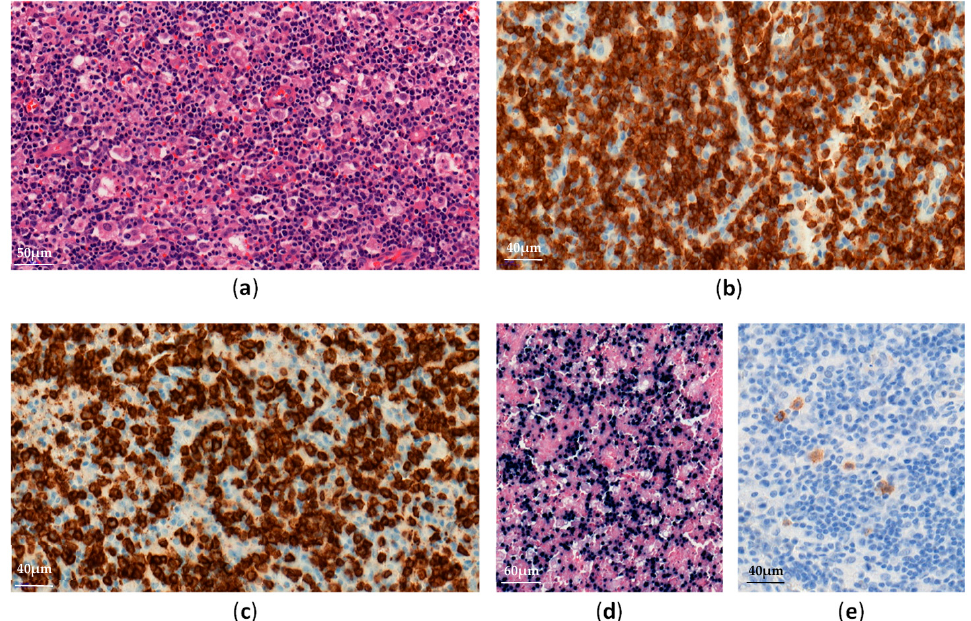
Figure 1. EBV-positive hemophagocytic lymphohistiocytosis in a lymph node: ( a ) Diffuse lympho- histiocytic infiltrate with hemophagocytosis (H&E × 300); ( b – e ) Atypical lymphoid cells are positive for CD3 ( b , ×400), CD8 ( c , ×400), EBV-encoded small RNA (EBER) ( d , ×200) and LMP1 ( e , ×400).